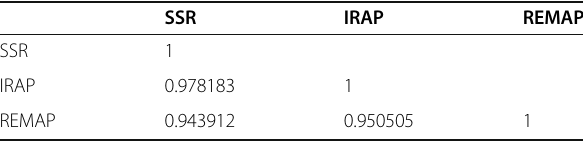
Table 4 Coefficients correlation ( r ) among the three markers with similarity matrices for each marker of SSR, LTR-IRAP, and LTR-REMAP markers in 20 citrus genotypes SSR IRAP